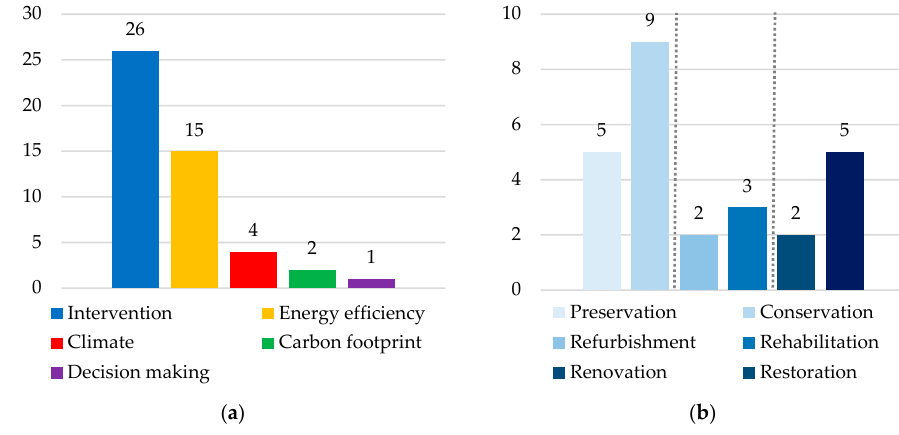
Figure 5. Findings from the systematic literature review: ( a ) categorisation of the documents presenting methodological approaches by primary driver; ( b ) categorisation of the documents describing a methodologic approach in maintenance and refurbishment by level of